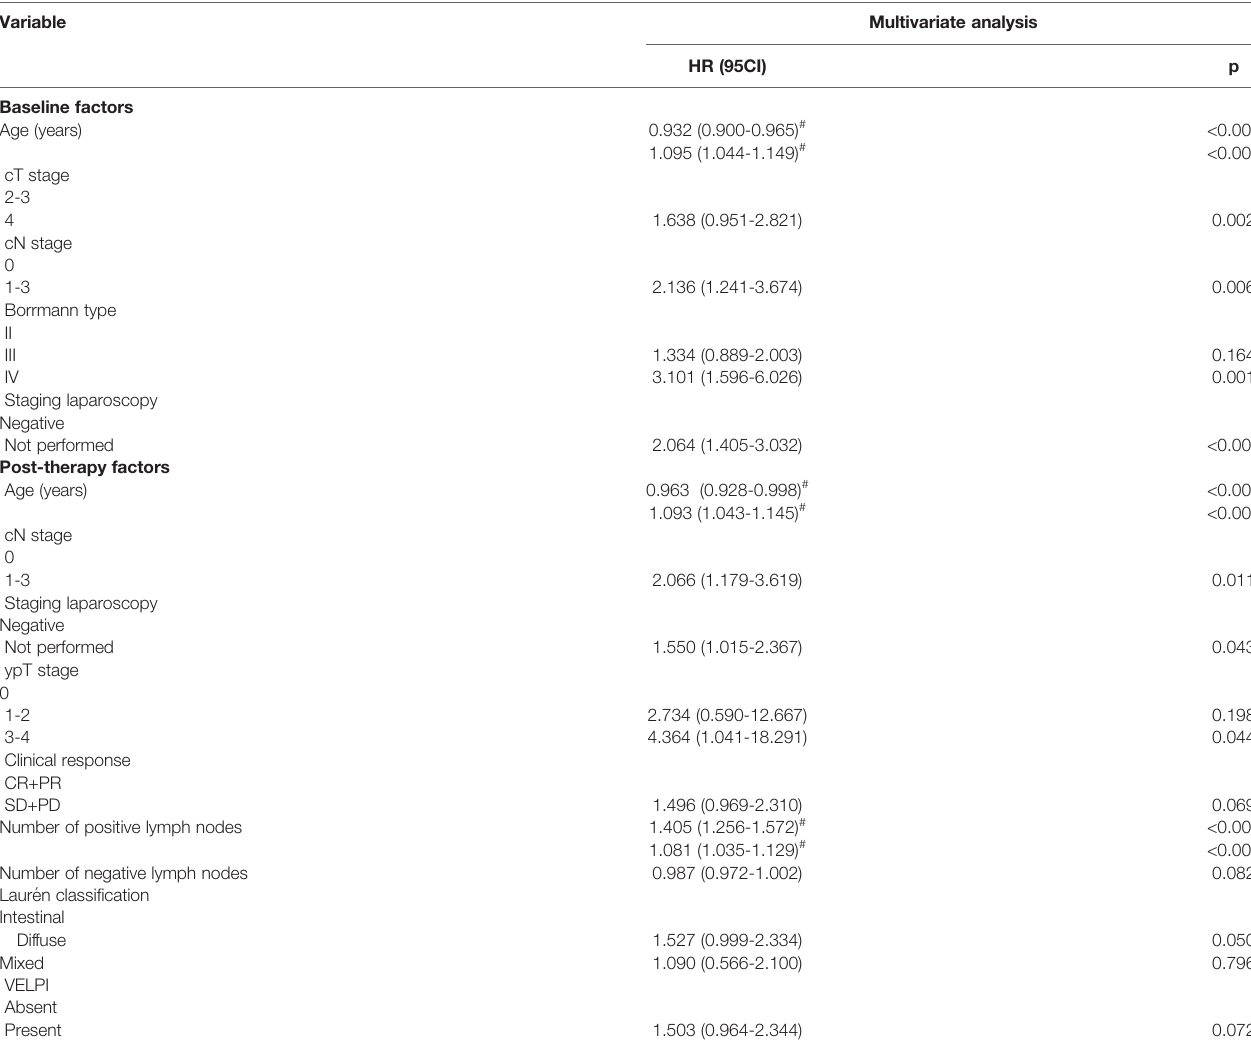
TABLE 2 | Multivariate analyses for disease-free survival of baseline and post-therapy